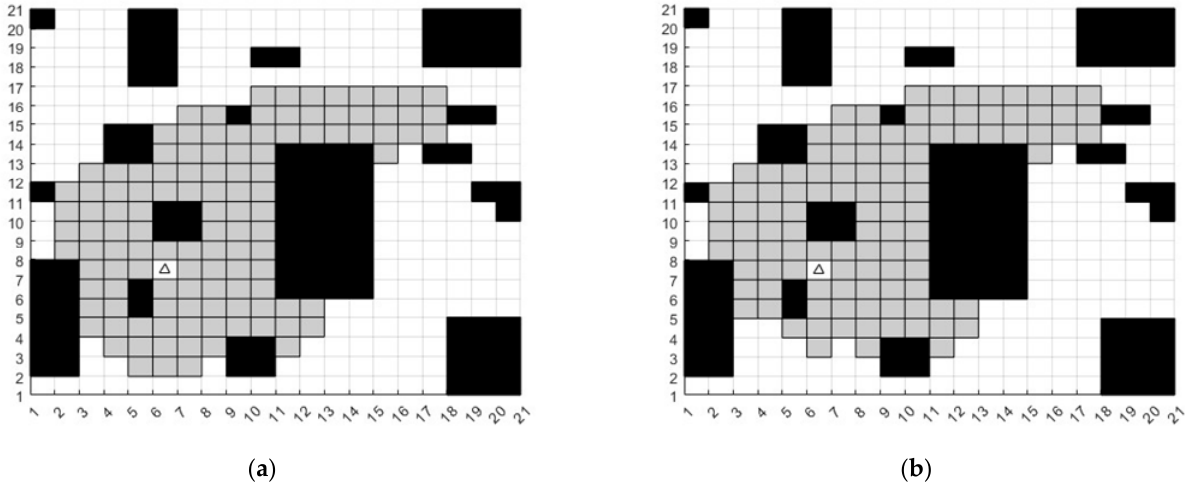
Figure 6. ( a ) 8-search direction simulation, ( b ) 5-search direction simulation.